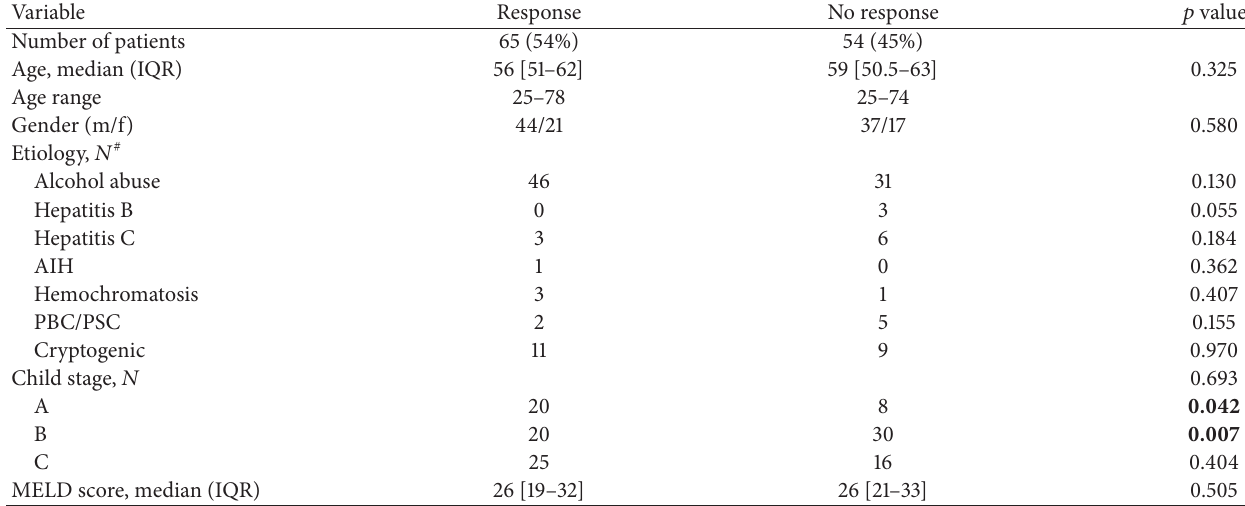
Table 1: Baseline characteristics of the patient cohort.